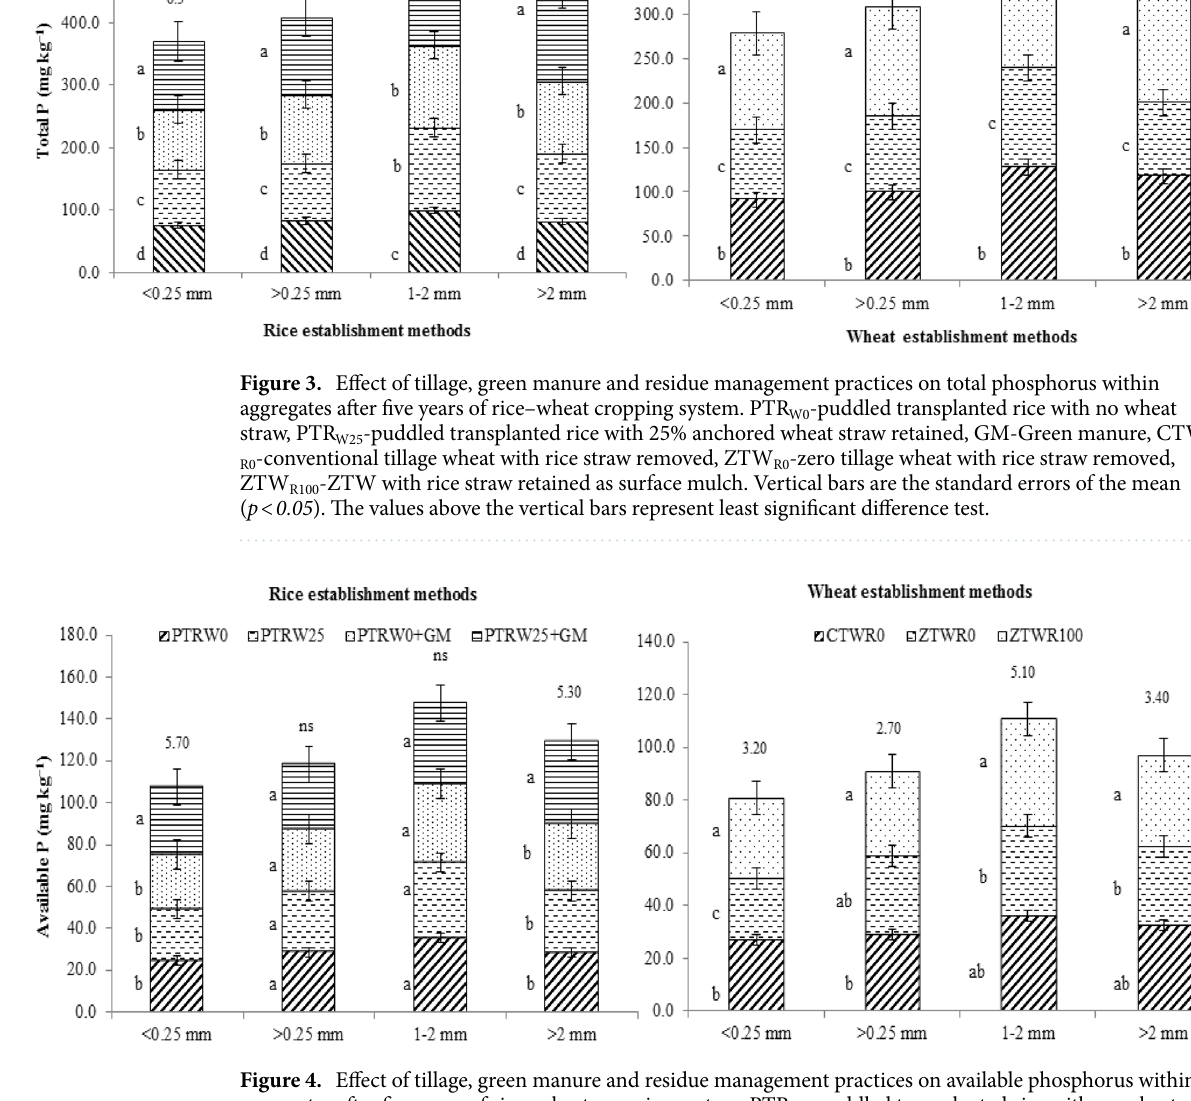
Figure 4. Effect of tillage, green manure and residue management practices on available phosphorus within aggregates after five years of rice–wheat cropping system. PTR W0 -puddled transplanted rice with no wheat straw, PTR W25 -puddled transplanted rice with 25% anchored wheat straw retained, GM-Green manure, CTW R0 -conventional tillage wheat with rice straw removed, ZTW R0 -zero tillage wheat with rice straw removed, ZTW R100 -ZTW with rice straw retained as surface mulch Vertical bars are the standard errors of the mean ( p < 0.05 ). The values above the vertical bars represent least significant difference